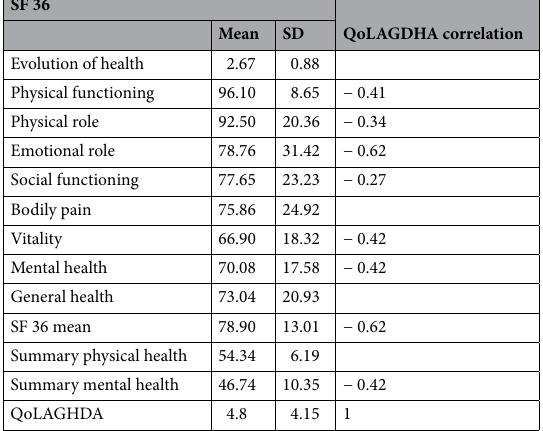
Table 3. Overall results of the quality of life questionnaires. All showed correlations p <